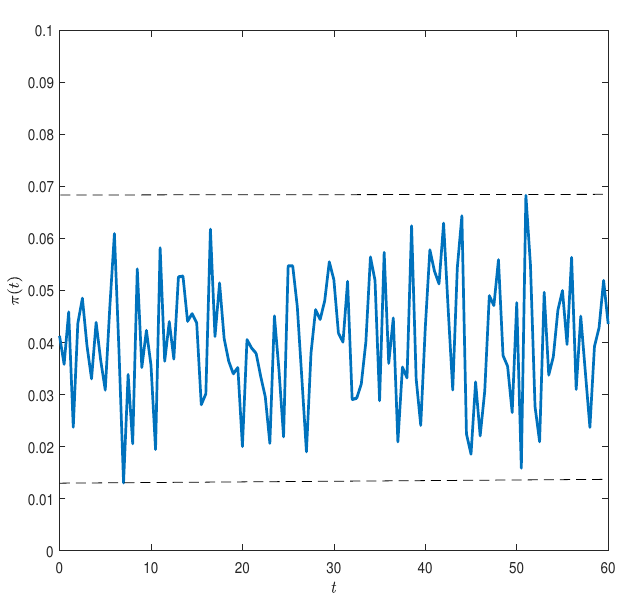
Figure 5. Optimal proportion of risky assets π ( t ) as a function of t